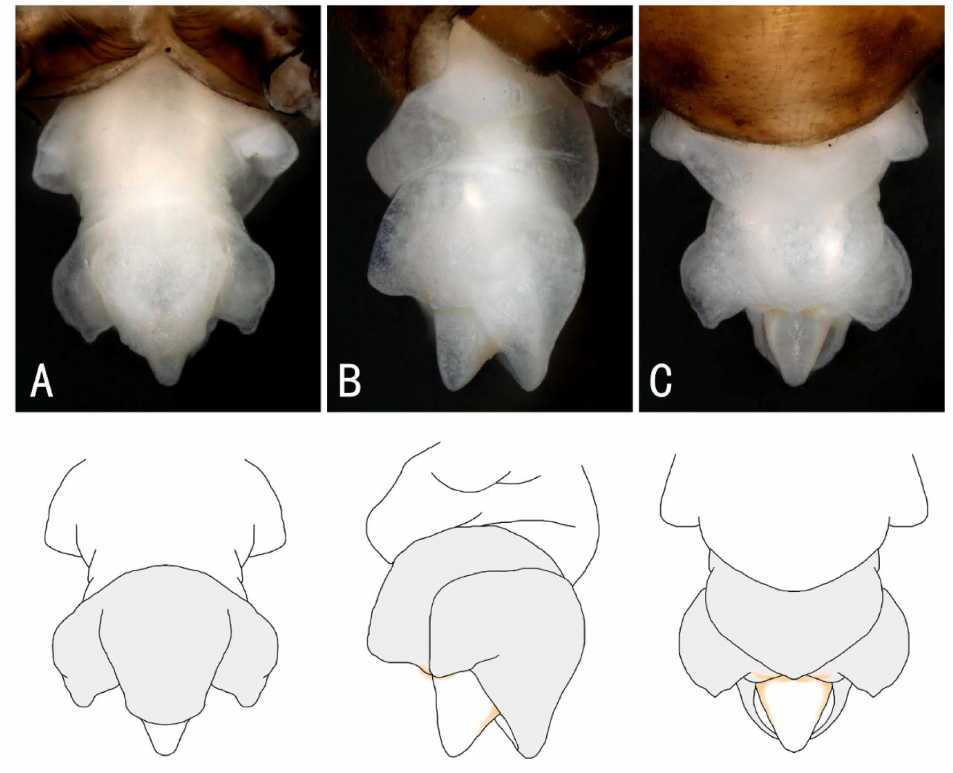
Figure 4. Filchneria songi , everted aedeagus. ( A ) dorsal; ( B ) lateral; ( C )